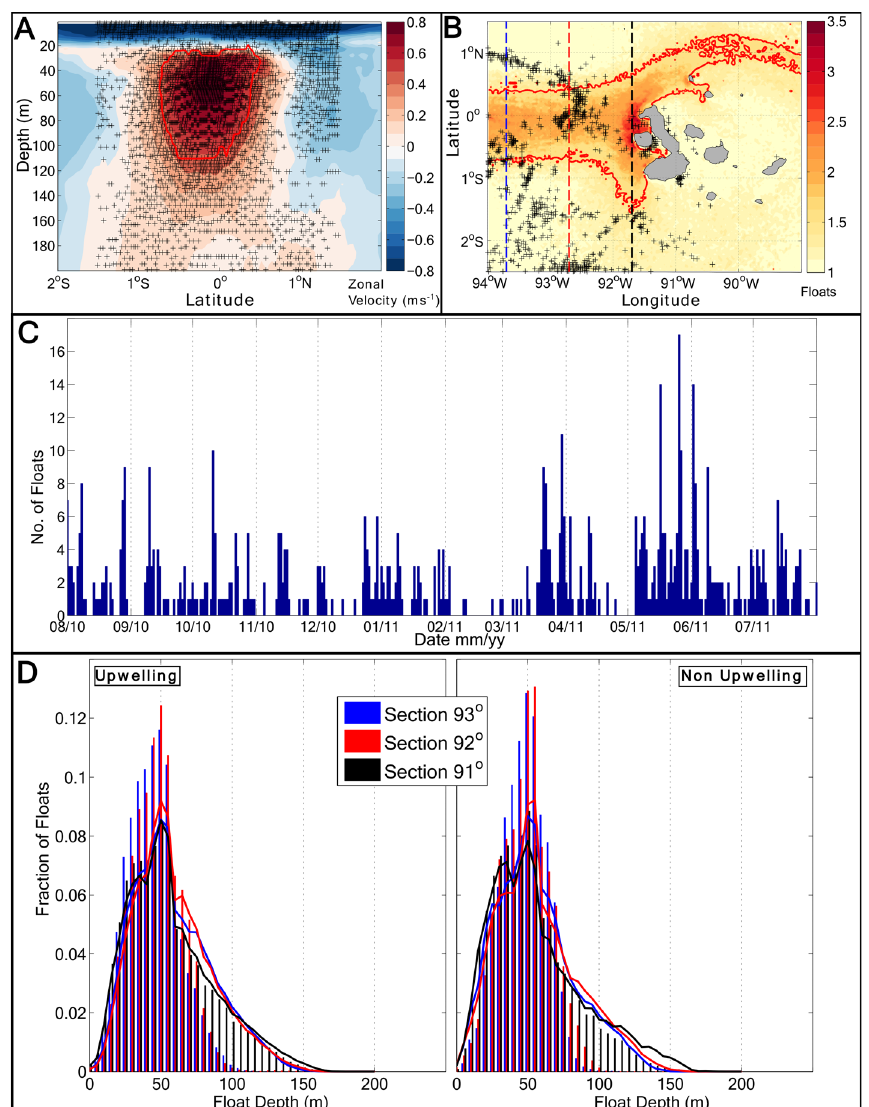
Figure 4. Float depth and positions from the model float release experiments. ( A ) Float deployment positions, marked with black crosses (only every fifth float shown for clarity), and zonal velocity for a typical float deployment. The red contour indicates floats identified as being in the Equatorial Undercurrent (EUC) core. ( B ) Mean per-release float density for all floats passing through the analysis region. Black crosses indicate the positions at which floats enter the model mixed layer. The red contour denotes a mean float density of 1.5 per model grid cell. Coloured dashed lines indicate the positions of the sections referred to in panel ( D ). ( C ) Number of floats entering the model mixed layer for each day of the simulation from all float releases. ( D ) Distribution of depths of floats passing through the analysis region measured at three sections, at 93.7ºW (blue), 92.7°W (red) and 91.7°W (black), for upwelling and non-upwelling periods. Bar plots are for floats identified as being in the core of the EUC, and lines for all